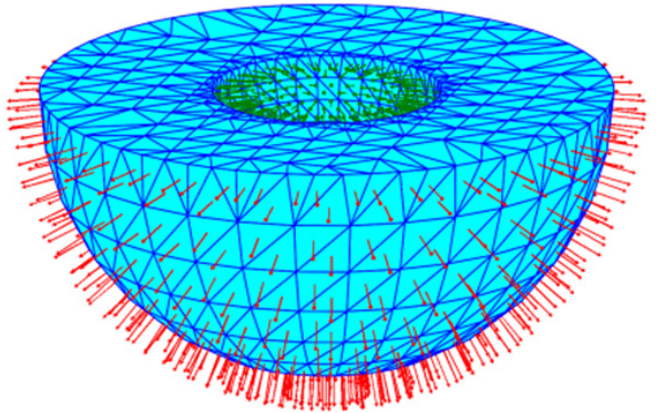
Figure 1. Triangulation strategy of 3D model.